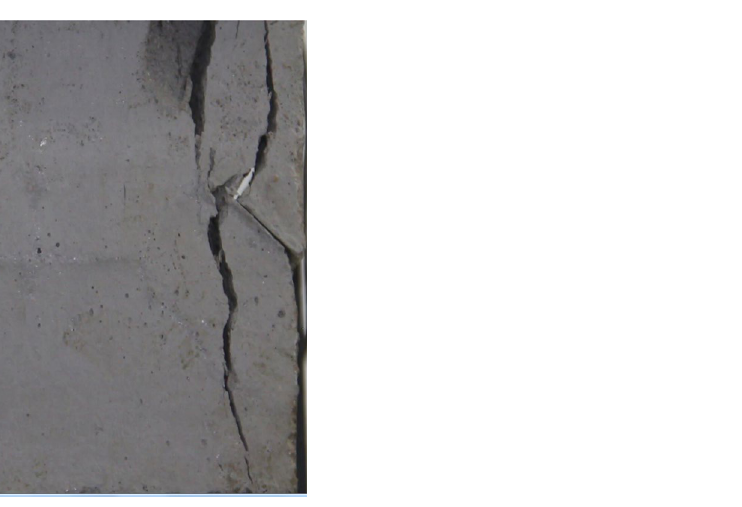
Figure 56. Photograph of a specimen showing anti-tensile wing crack propagating and crack